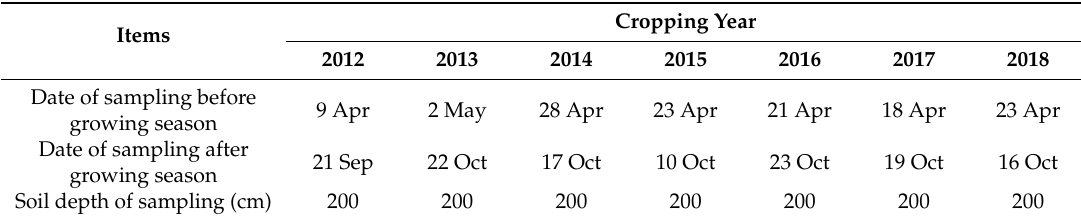
Table 2. Date of soil sampling before and after the growing season in each year and the sampled soil